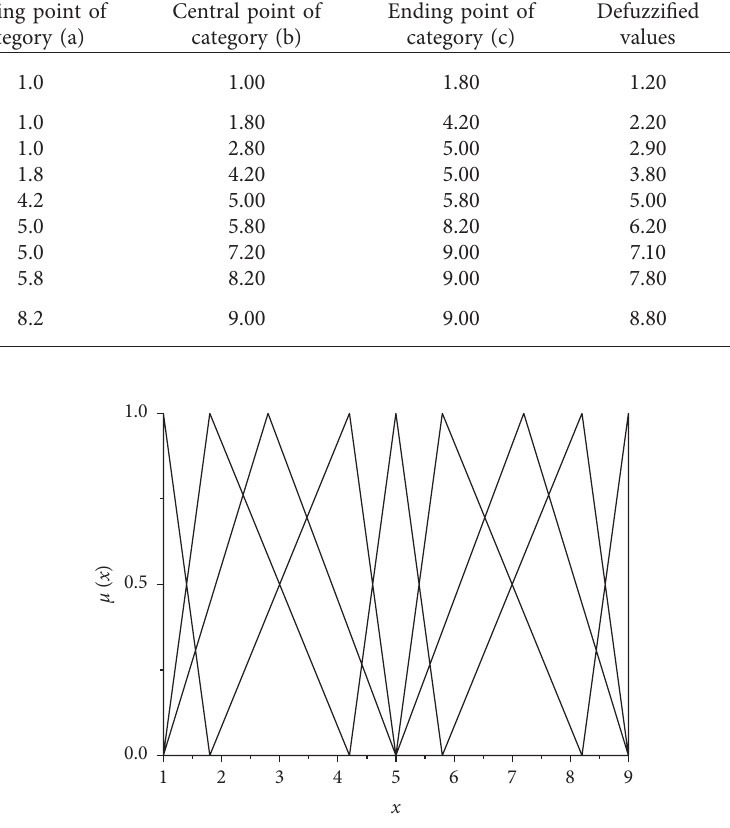
Figure 4: Graphic representation of the 9-point triangular fuzzy nonbalanced scale.